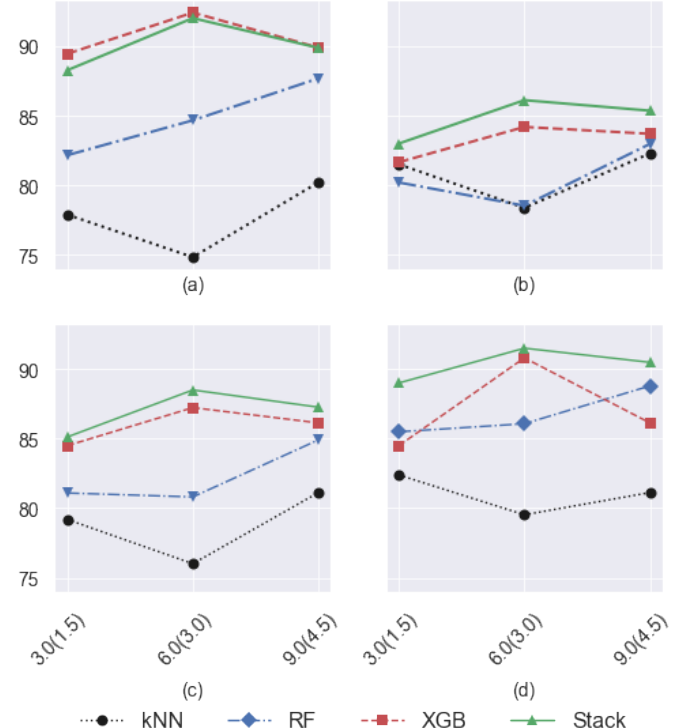
Figure 6. Comparison of the classifiers’ performance for the three different segment lengths: ( a ) PPV, ( b ) Se, ( c ) F 1 -score, and ( d ) Acc. The x-axis represents the segment’s length with their corresponding overlaps in the parentheses, i.e., S ( O )